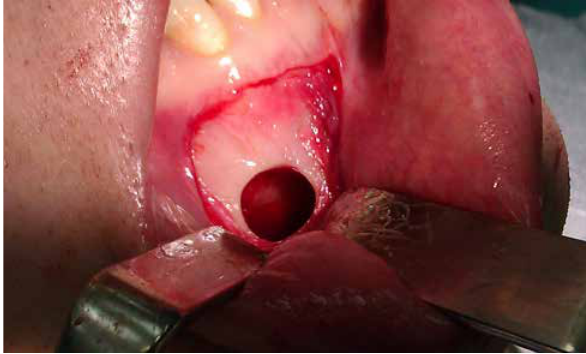
Figure 3: Patient A.R., age 32. Intraoperative photo. Visible opening made in body of mandible in region of teeth 42 – 43, providing access to tumour mass.